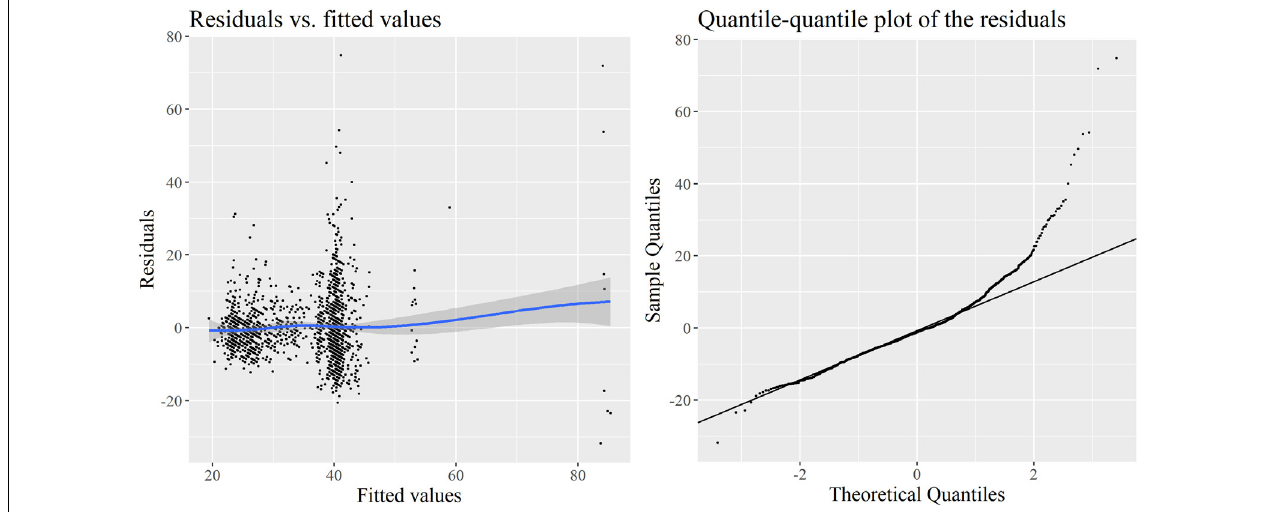
FIGURE 2 | Diagnostics for the LMM model: raw residuals vs. fitted values (left) and quantile-quantile plot of these residuals (right)